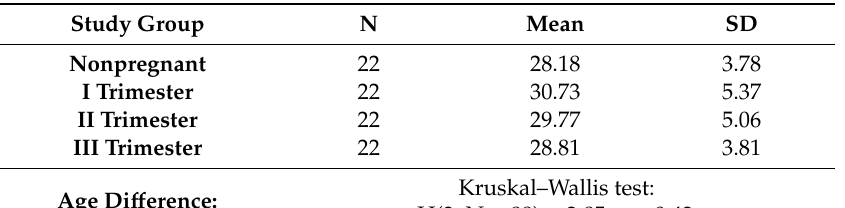
Table 1. Age of women in each study group.